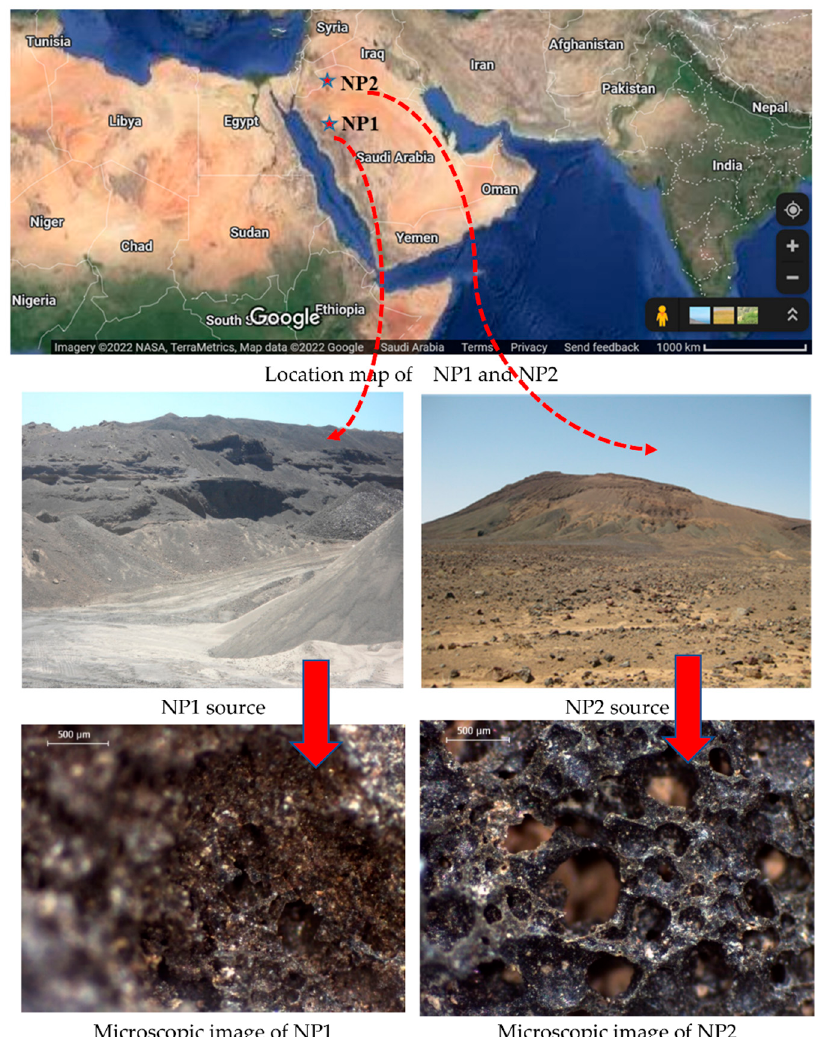
Figure 1. Optical microscopic investigation of typical NP1 and NP2 grains before grinding; location map is an actual satellite illustration of the two NP sources in the Kingdom of Saudi Arabia (Map data ©2022 Google).